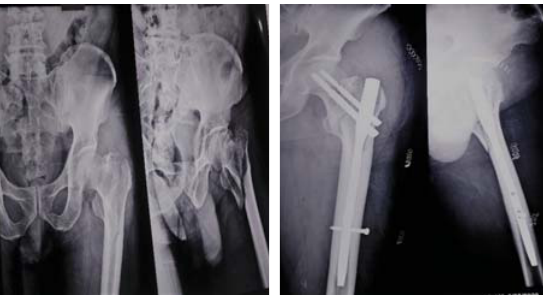
Figure 3. PFN radiograph (preoperative and immediate